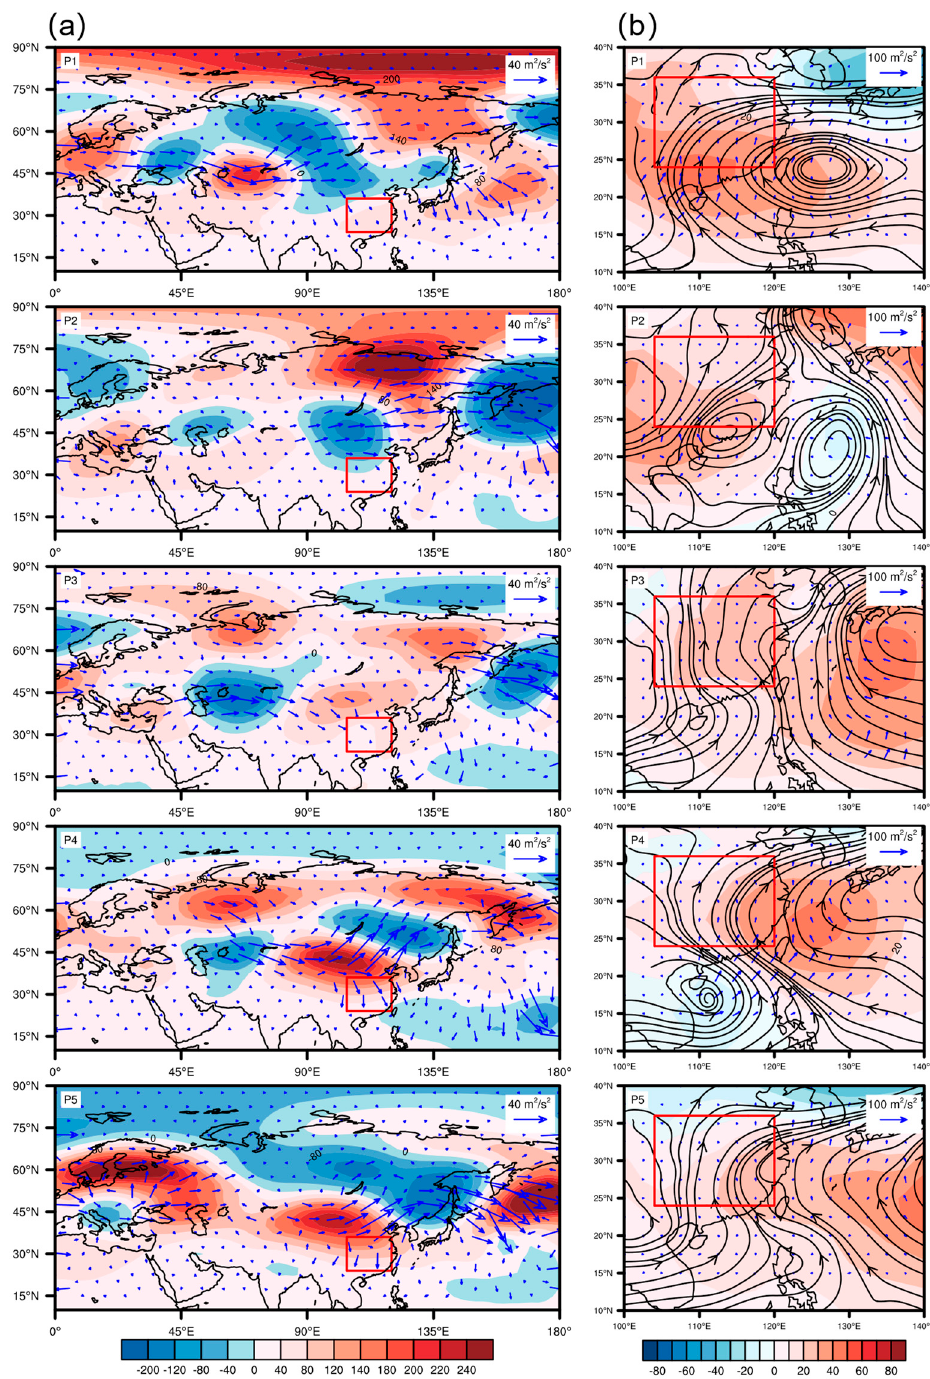
Figure 6. ( a ) TN wave flux (vectors; m 2 /s 2 ) and geopotential height anomalies (shading; gpm) in P1–5 at 200 hPa. ( b ) TN wave flux (vectors; m 2 /s 2 ), geopotential height anomalies (shading; gpm), and wind anomalies (streamlines; 𝑚/𝑠 ) in P1–5 at 800 hPa. The red box marks South China.